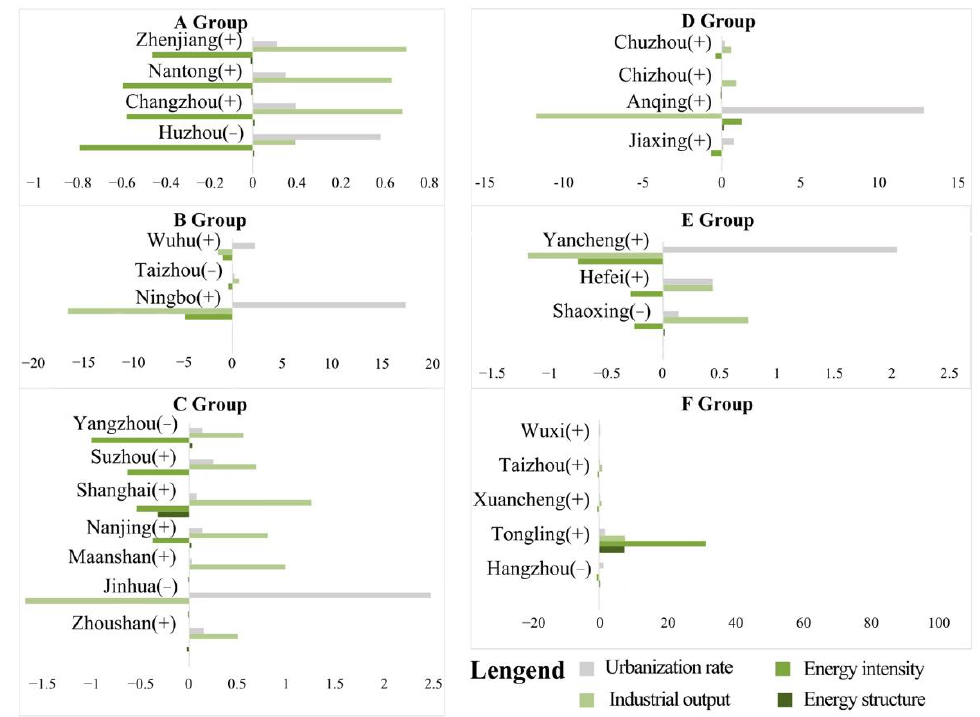
Figure 11. Cluster analysis results in the second five years (2005–2010).